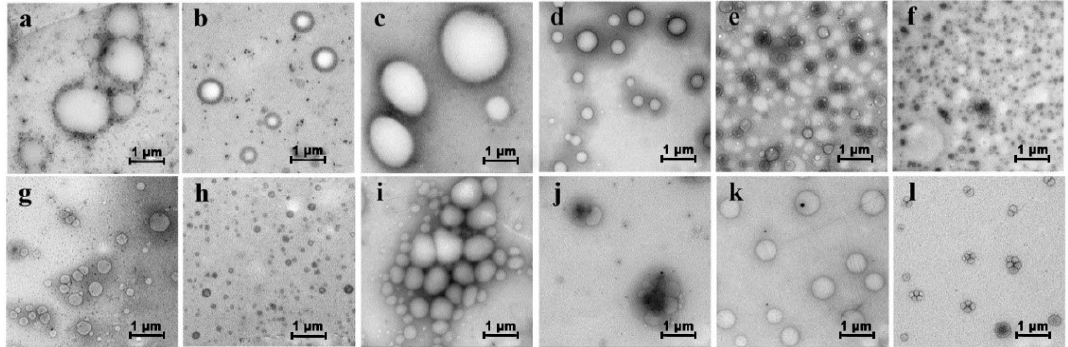
Figure 2. Morphologies of PGG when PGG solution was mixed with methanol ( a , g ), ethanol ( b , h ), isopropanol alcohol ( c , i ), acetone ( d , j ), THF ( e , k ), and 1,4-dioxane ( f , l ) at solution/solvent ( v/v ) ratios of 1:1 ( a – f ) and 1:2 ( g – l ).